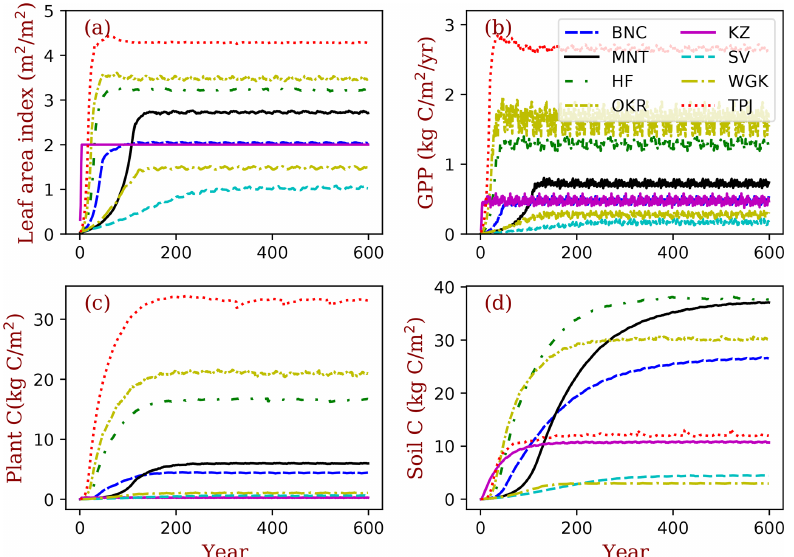
Figure 4. Site ecosystem development simulated by BiomeE with full demography for the field sites listed in Table 2. GPP is the